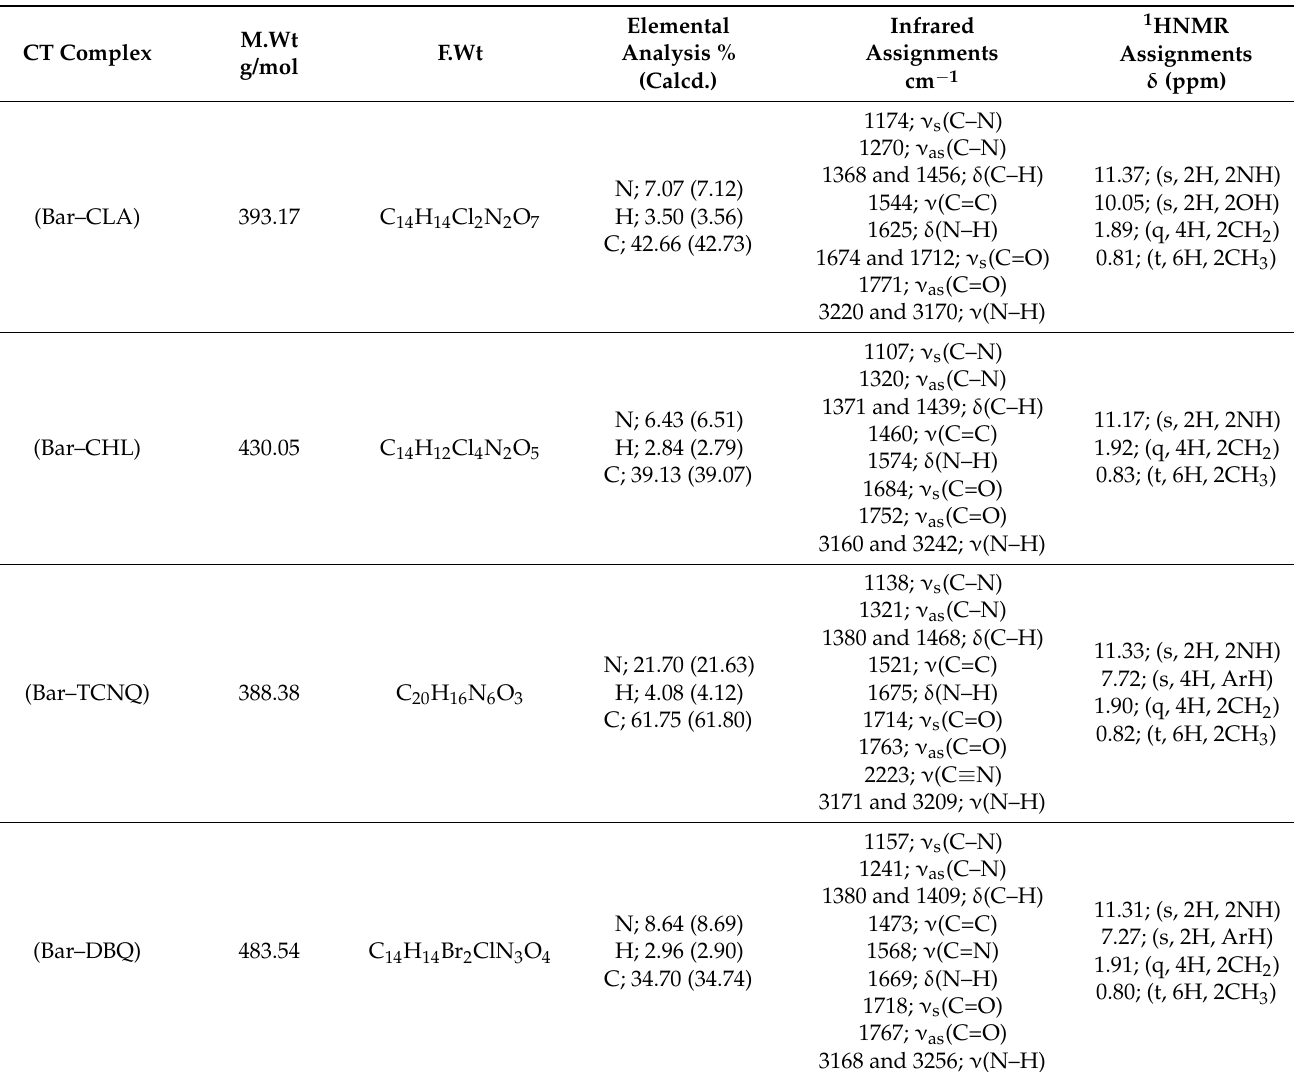
Table 1. The spectroscopic characterization of all Barbital CT